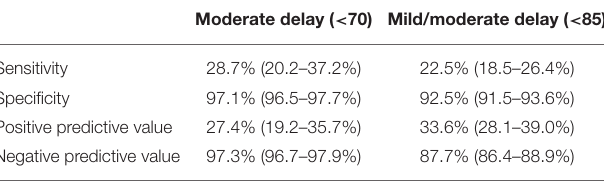
TABLE 2 | Sensitivity, specificity, positive, and negative predictive values for Bayley-III cognitive score at 6 months at predicting 24-month outcomes in moderate delay ( < 70) and mild/moderate delay ( <